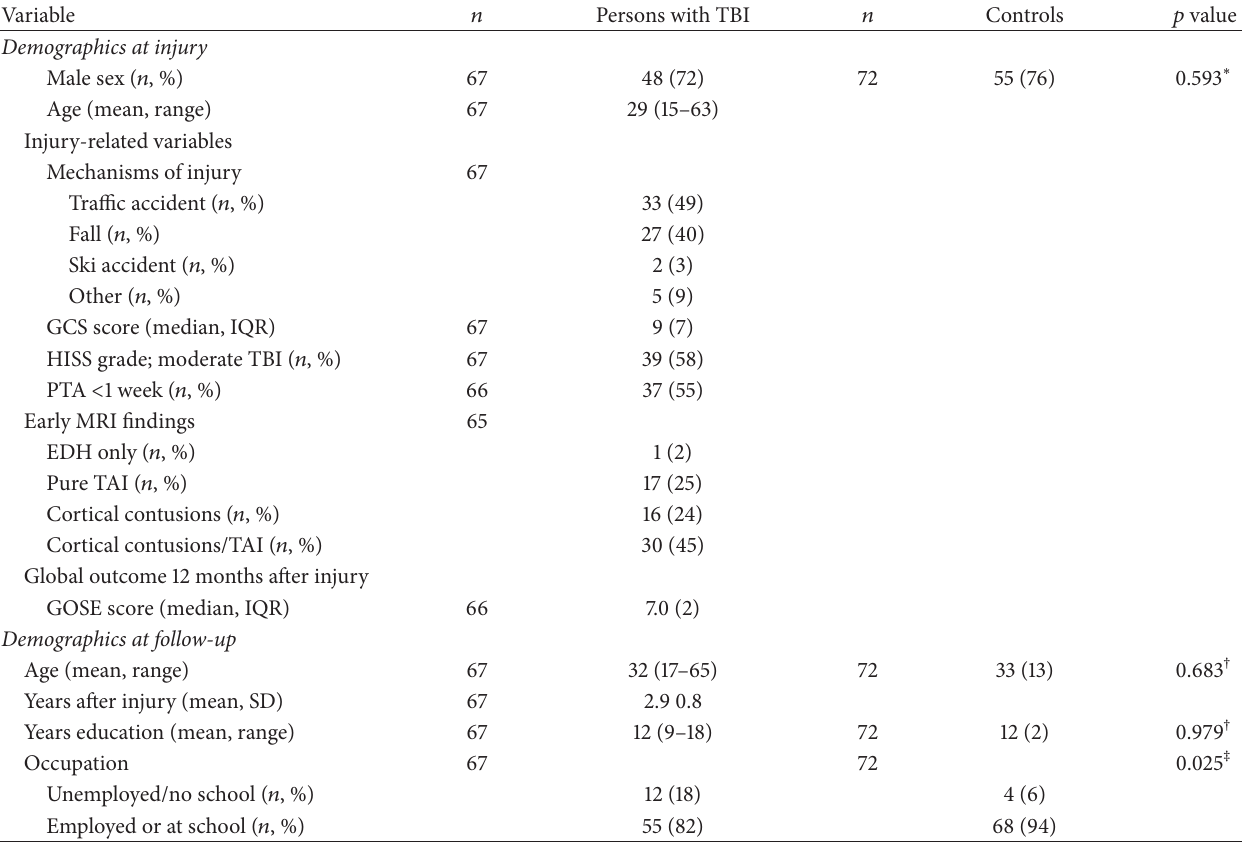
Table 2: Description of participants: demographics, injury severity characteristics, and clinical observations at 1 and 2–5 years after moderate and severe TBI: global outcome and